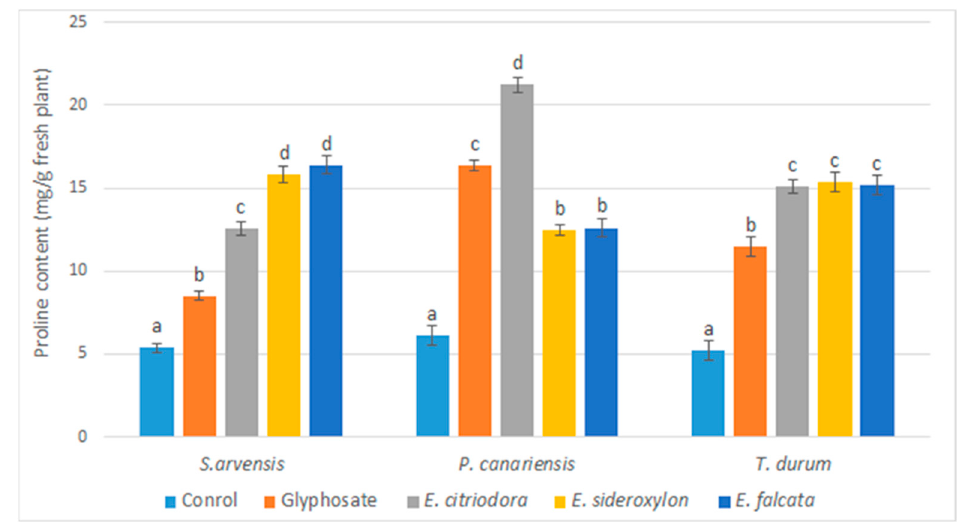
Figure 8. Effects of Eucalyptus essential oils and glyphosate on proline content as mg/g fresh tested plants measured five days after application. Error bars and letters on graphs represent standard error means and significant differences at p ≤ 0.05 through Student–Newman–Keuls.